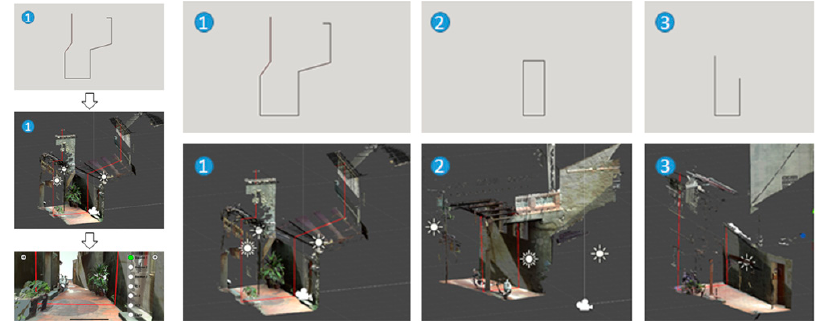
Figure 4. Approaching views of Shih Yih Hall from near to distant ( top ) and from the other direction ( bottom ).